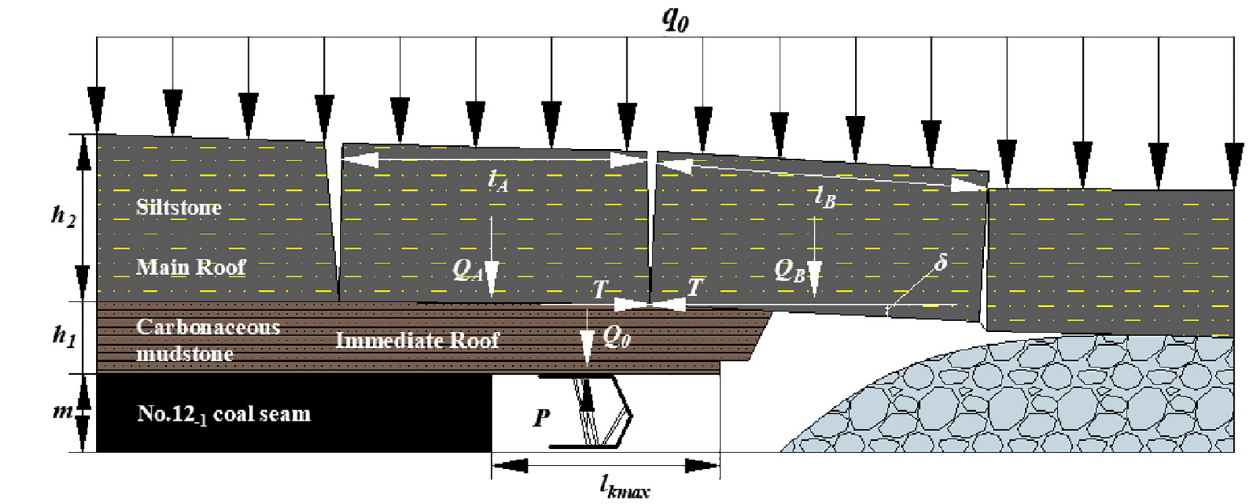
Fig 11. Roof structure characteristic after No.12 -1 coal seam